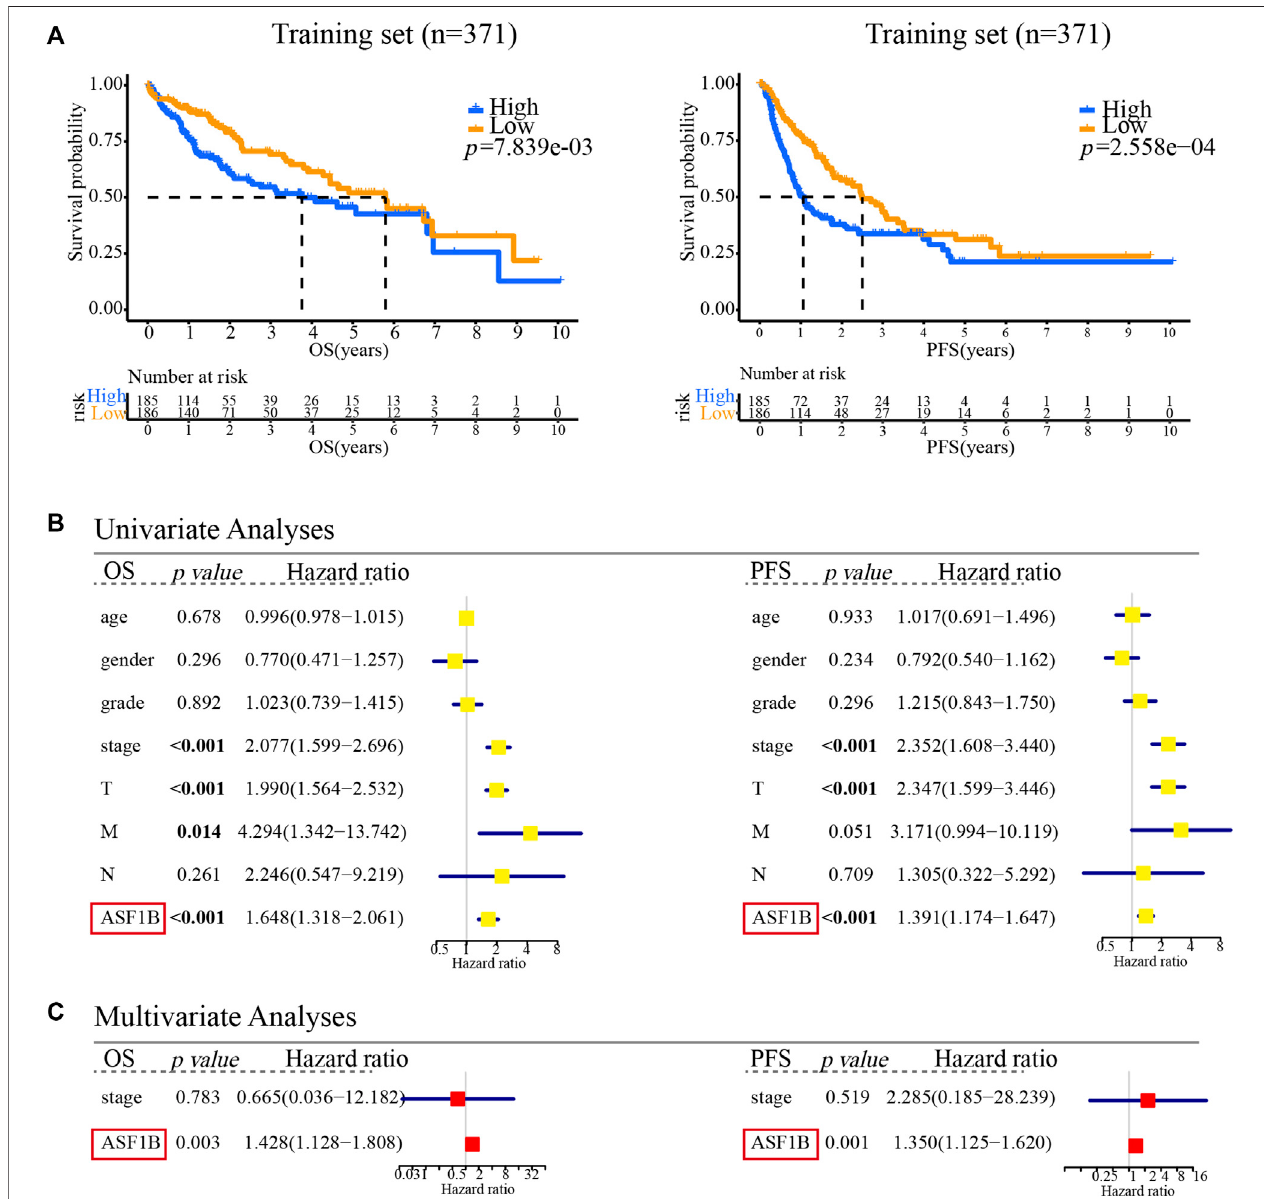
FIGURE 3 | Multifaceted prognostic value of ASF1B in the training set. (A) Kaplan-Meier estimates of OS and PFS according to the level of ASF1B mRNA among TCGA LIHC cases. Training set, OS ( p < 0.001), PFS ( p < 0.001); (B) Univariate Cox regression analyses of OS and PFS related factors among TCGA LIHC cases; (C) Multivariate Cox regression analyses of OS and PFS related factors among TCGA LIHC